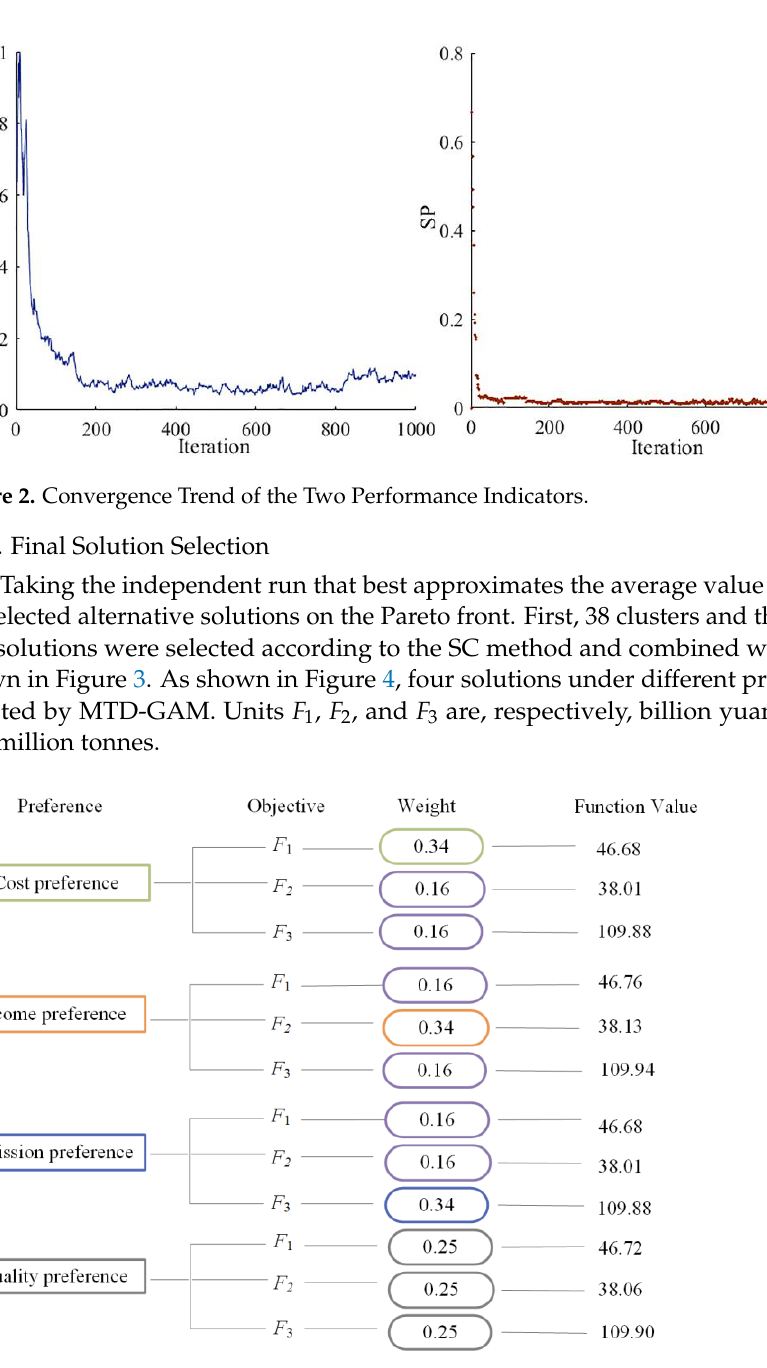
Figure 3. Weights and Objective Function in Four Preferences.